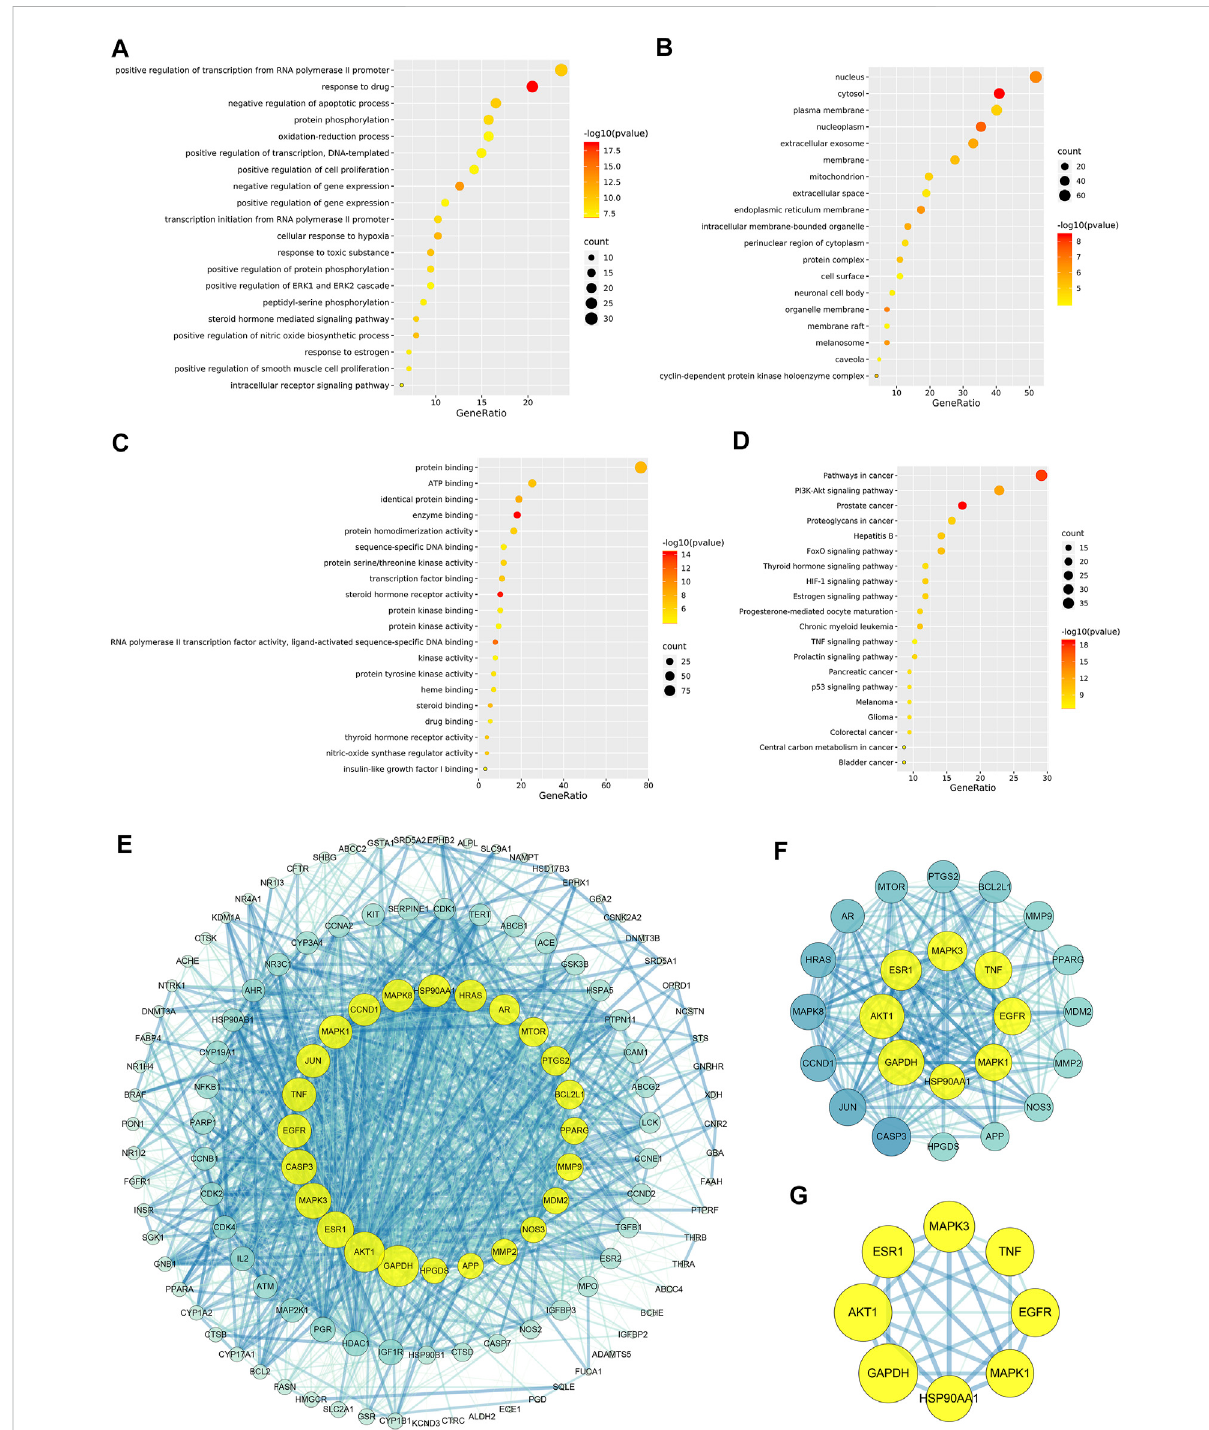
FIGURE 5 The enrichmentandPPI analysesoftheCCMM-MI common targets ( p -value ≤ 0.05). (A) The twenty mostimportant biologicalprocesses. (B) A totalofnineteencell components. (C) Thetwenty mostimportant molecular functions. (D) Alist ofthetop twentyKEGGpathways.Thecolorgrades represent various p -value thresholds, and the sizes of the dots indicate the number of targets correlated with each phrase. (E) The PPI network of CCMMandMI. (F) ThePPInetworkbythescreeningcriteriaofDC ≥ 41. (G) DC ≥ 60,BC ≥ 0.025,andCC ≥ 0.651wereusedasscreeningcriteria for thePPI network. The node ’ ssize and color indicate thedegreeof thetarget protein. The width and color of the edge indicate the target protein ’ s combined